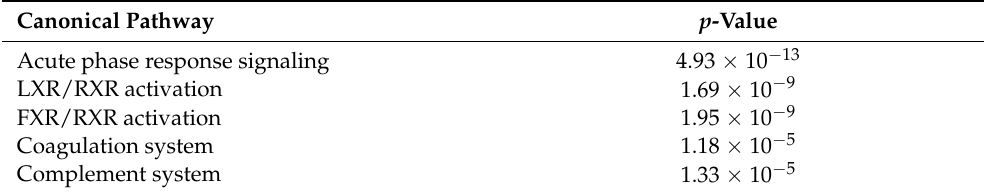
Table 2. The top five canonical pathways predicted in Ingenuity Pathway Analysis for differentially expressed proteins in sSS-DED patients versus pSS-DED patients.